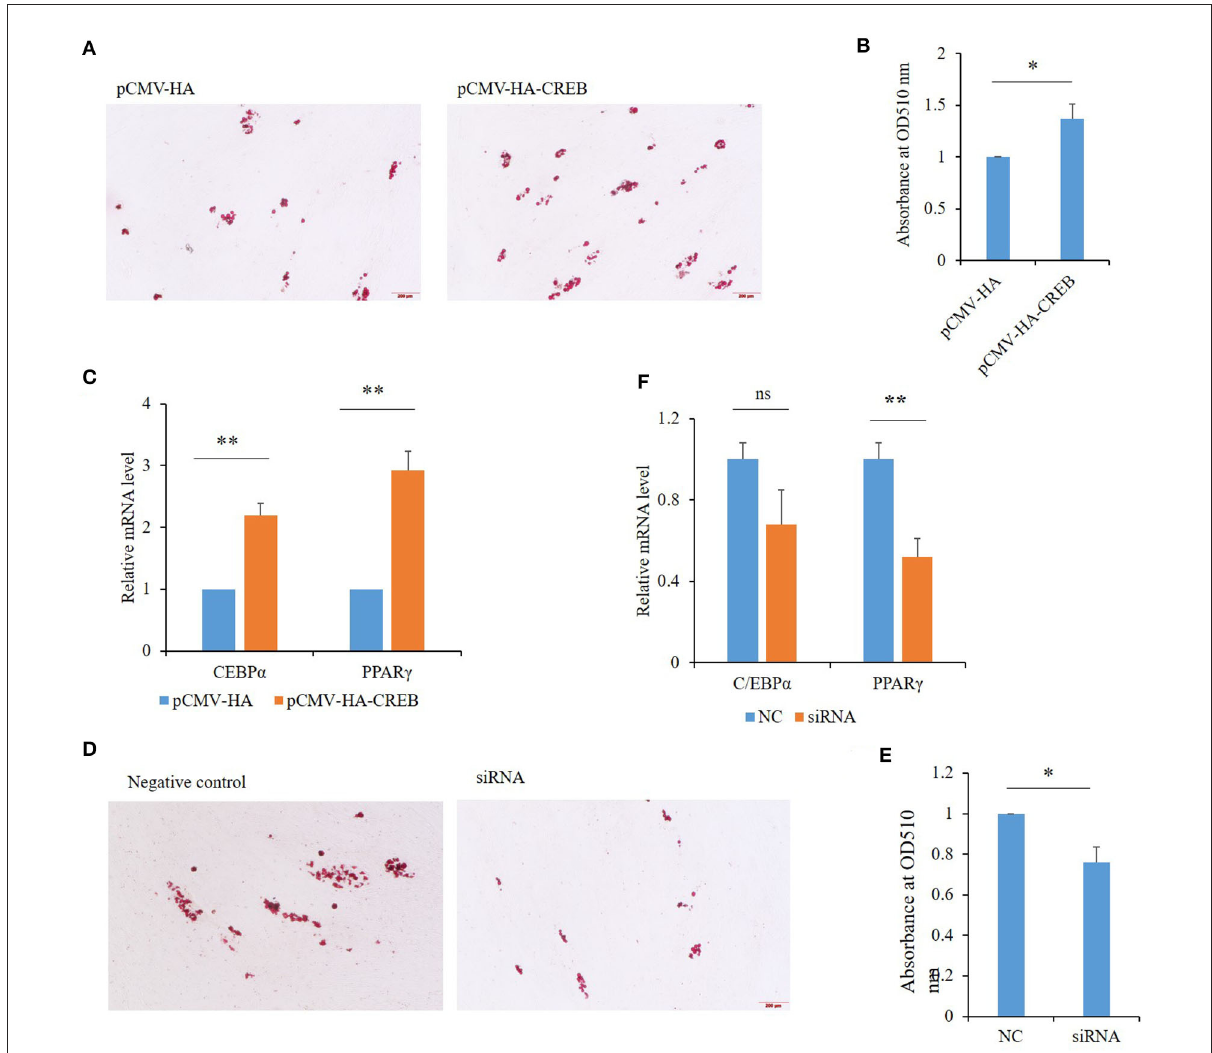
FIGURE5 Effects of CREB1 on porcine preadipocyte differentiation. (A) Oil Red O staining of preadipocytes overexpressing CREB1 gene at 8 days post-induction; (B) quantitative analysis of triglyceride contents in preadipocytes overexpressing CREB1 gene with optical absorbance; (C) expression of C/EBP α and PPAR γ in preadipocytes overexpressing CREB1 gene; (D) Oil Red O staining of preadipocytes knocked down for CREB1 gene at 8 days post-induction; (E) quantitative analysis of triglyceride contents in preadipocytes knocked down for CREB1 gene with optical absorbance; (F) expression of C/EBP α and PPAR γ in preadipocytes knocked down for CREB1 gene. * p < 0.05, ** p <